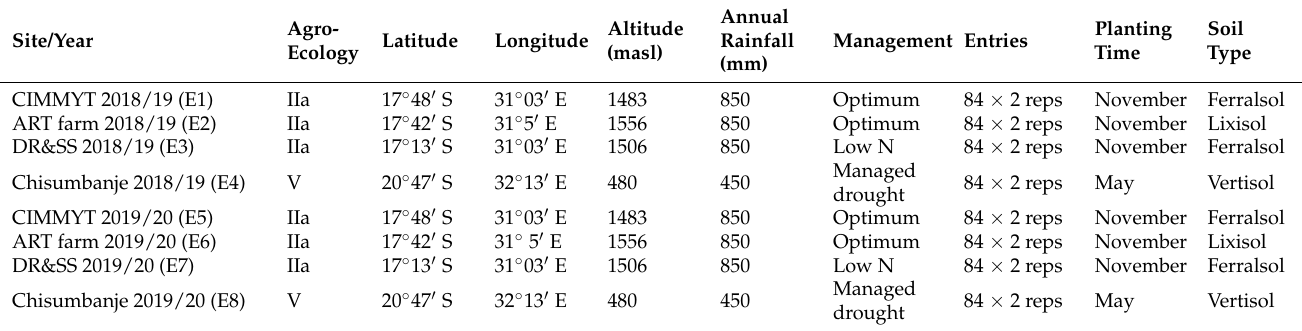
Table 7. Description of experimental sites, planting dates and crop management